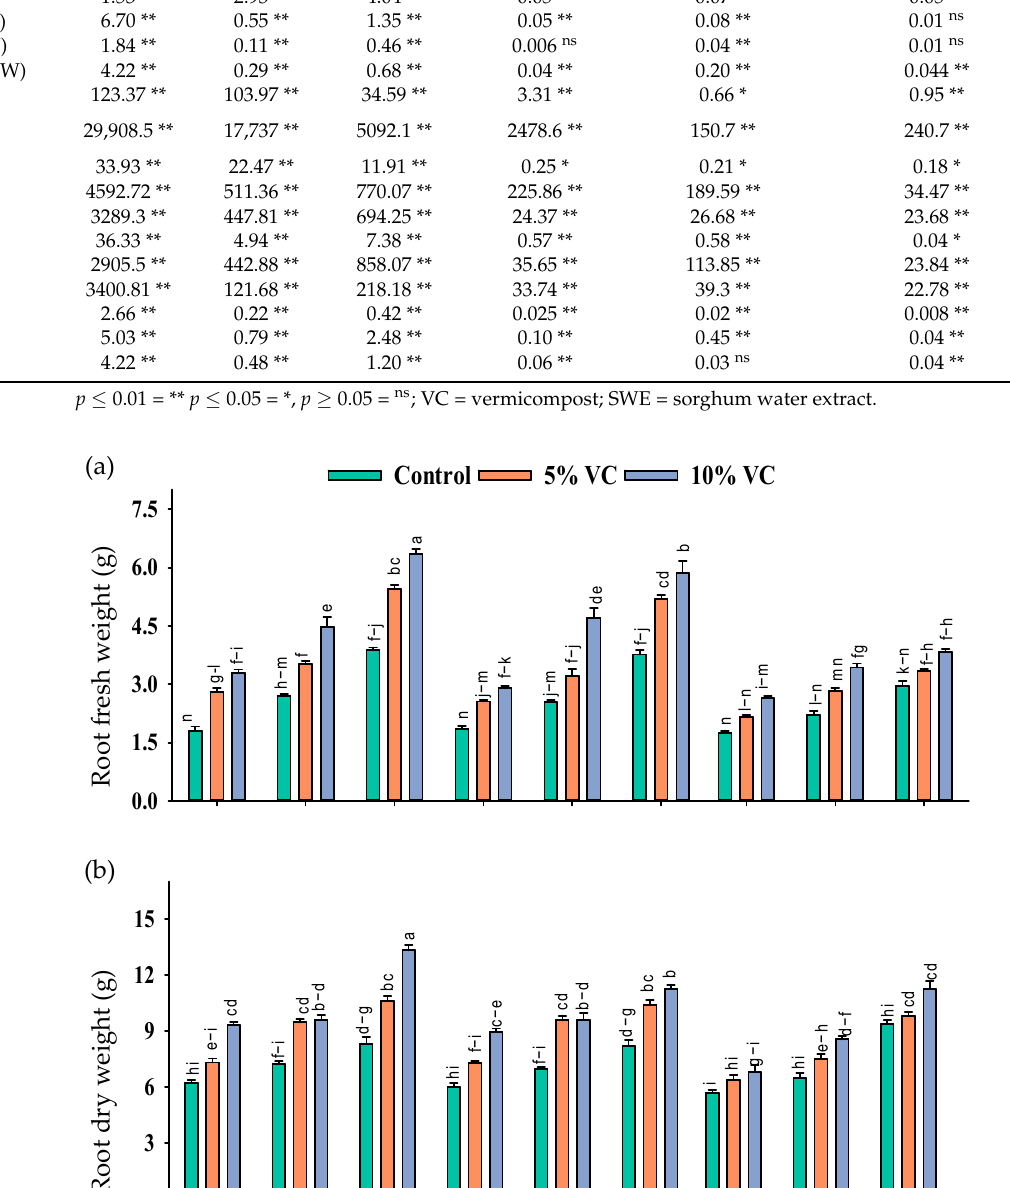
Table 1. Mean sum of square summary related to the effect of vermicompost and foliar-applied sorghum water extract on morphological attributes, photosynthetic pigments, enzymatic antioxi- dants, ionic contents, and H 2 O 2 and malondialdehyde (MDA) contents.